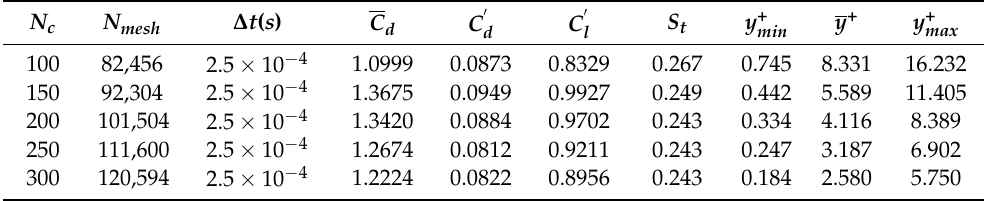
Table 1. Comparisons of the global parameters for the grid independence